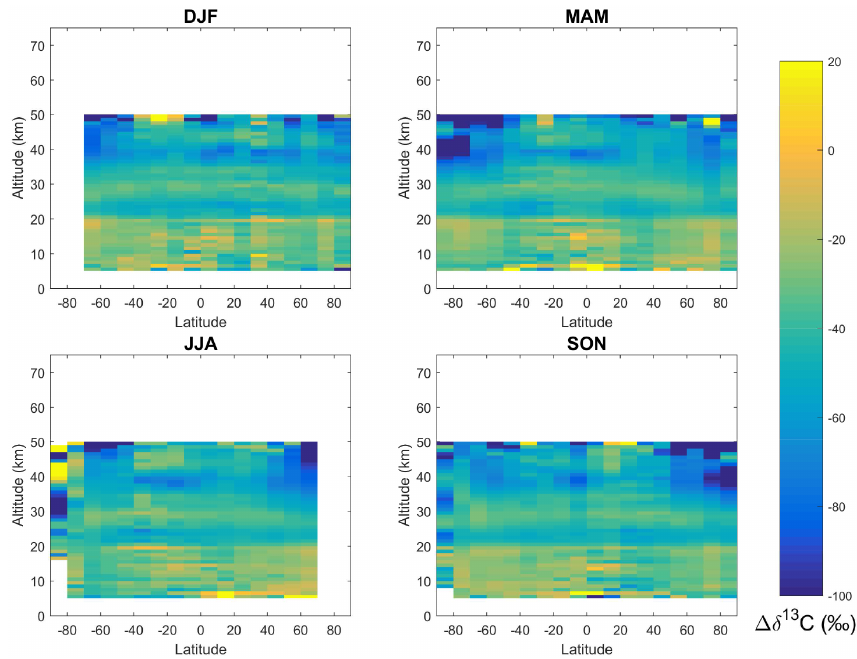
Figure 11. The difference in δ 13 C between ACE and WACCM. Negative values are given when ACE reports a larger value than